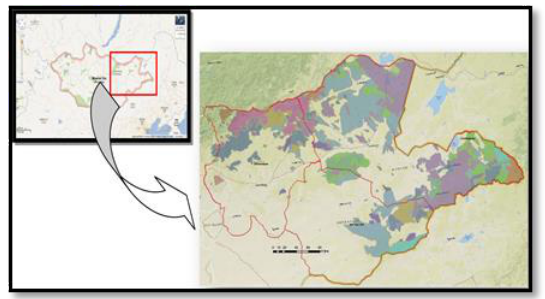
Figure 1. The study area Eastern part of Mongolia